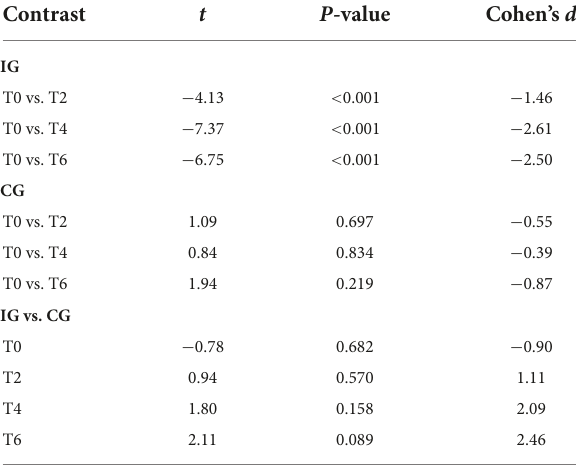
TABLE 2 Results of post hoc test of the VO 2max within and between IG and CG.